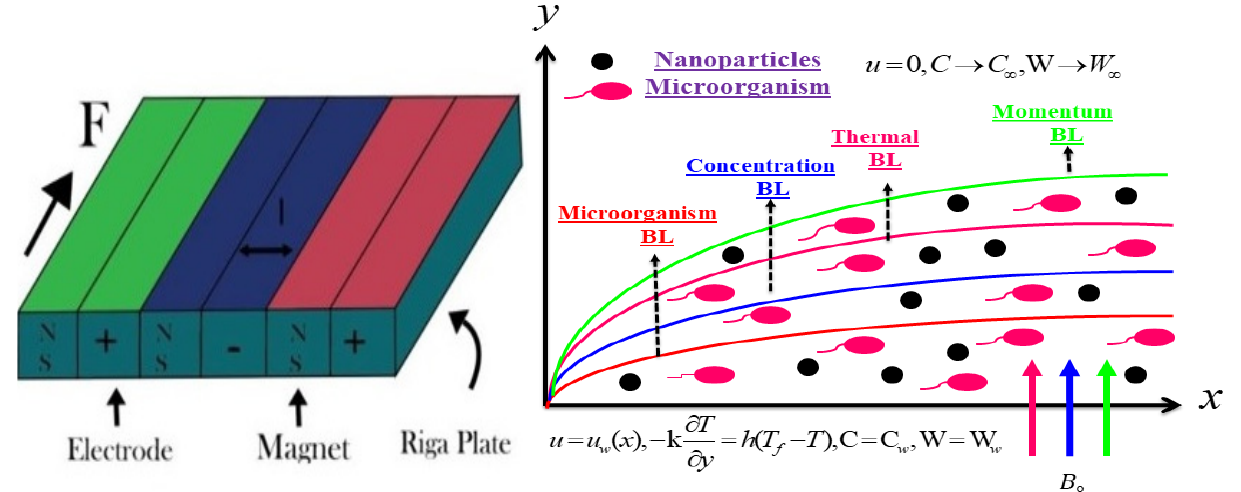
Figure 1. Physical configuration of the flow problem.